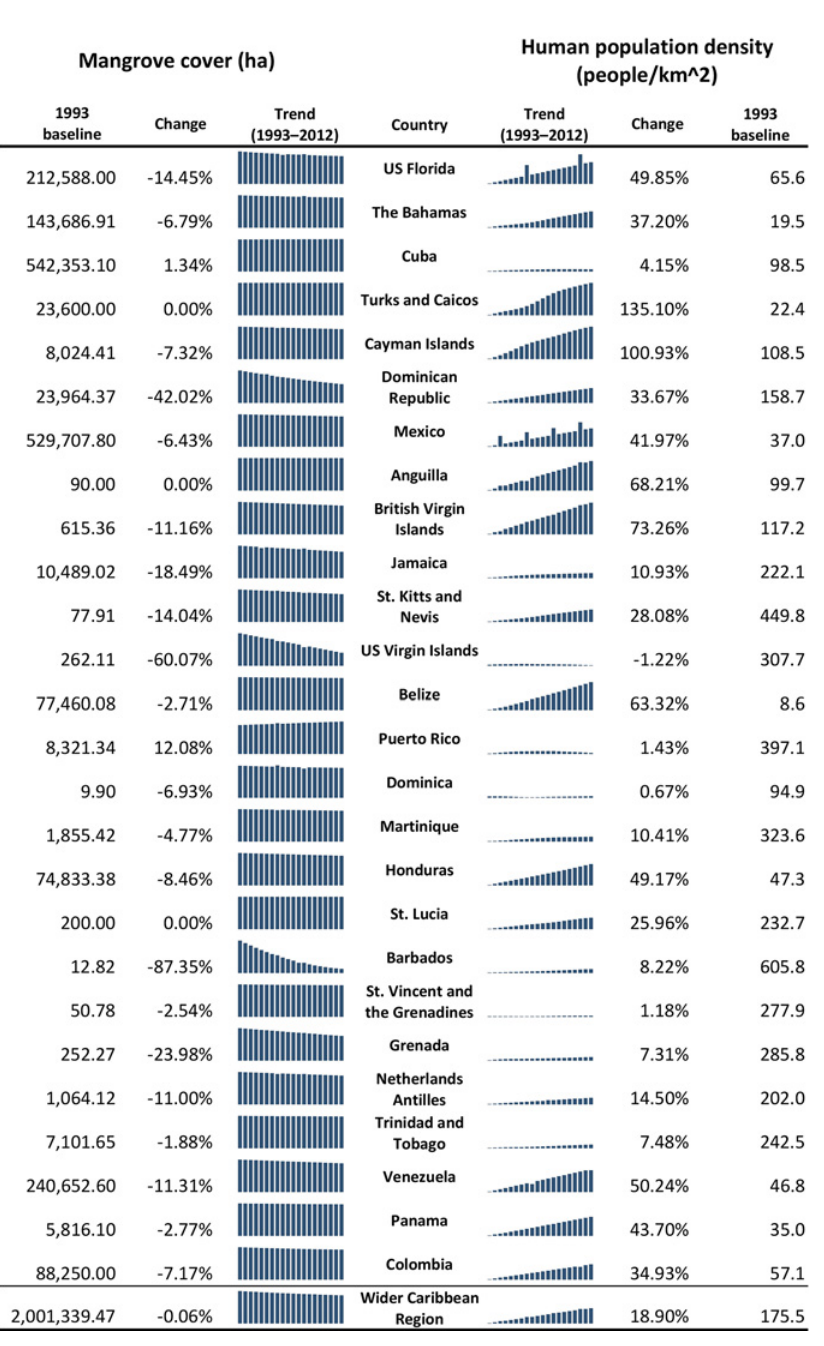
Fig 2. Summary of mangrove extent and human population density data from 1993 to 2012. See Methods for details on where mangrove data and population data are derived. Percent change is the difference between 1993 and